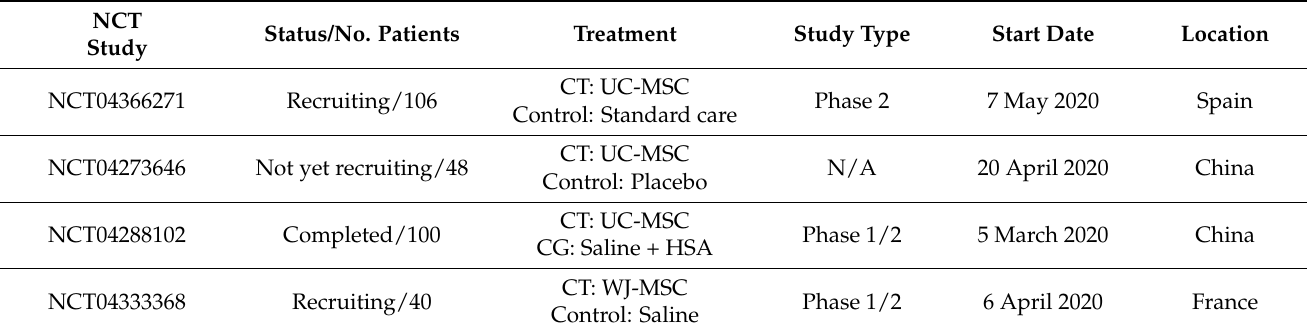
Table 3. Clinical trials of perinatal-derived mesenchymal stromal cells registered in https://clinicaltrials.gov for